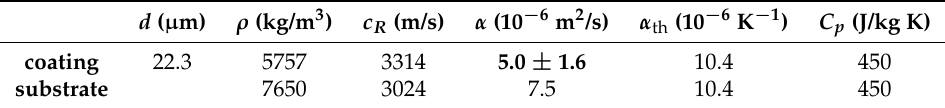
Figure 15. Set of time signals as extracted from the most dominant wavenumber components resulting from the thermoelastic excitation using grating spacings between λ = 18 and 120 µ m. As a result, of the long the thermal decay rate of the λ = 120 µ m line the signal was cut by the recording oscilloscope before it effectively became zero. Also, the best fitting curves according the two-layered thermal limit of the thermoelastic model (solid gray line) and a fit with a complementary error function (dashed black line) with a distinct effective diffusivity for each wavelength line are shown. Table 4. Assumed values for the fixed thermoelastic parameters in the fitting process aiming at the extraction of the thermal diffusivity of the coating in the GESA modified material. The best fitting thermal diffusivity of the coating layer is printed in